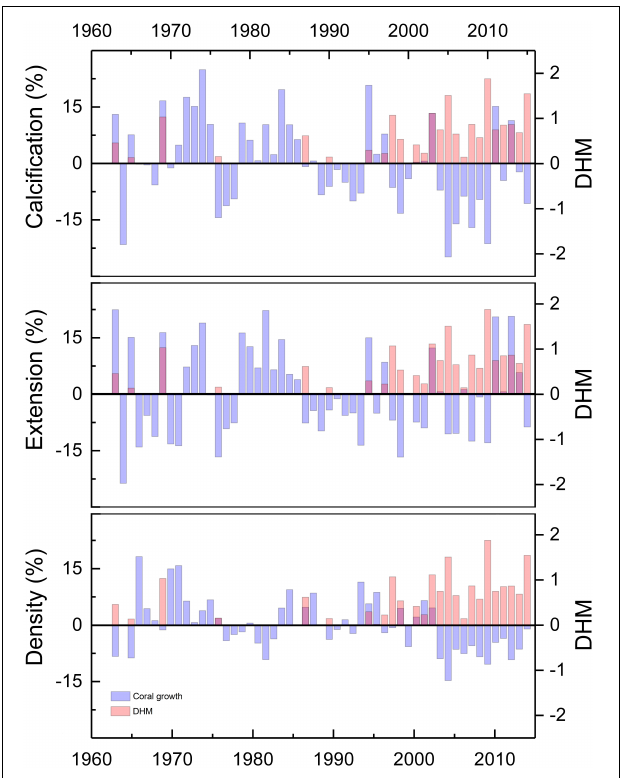
FIGURE 4 | Percentage of inter-annual variations (relative to historical mean) of growth parameters and their relationship with the annual values of degree heating months (DHM).